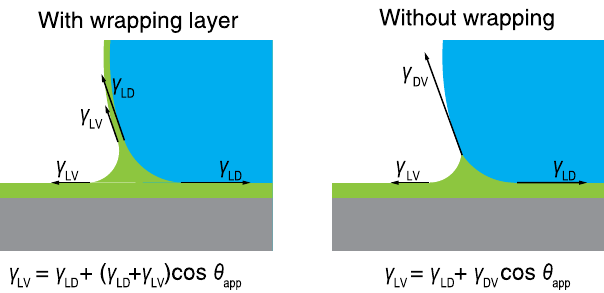
FIG. 7. The apparent contact angle θ of solely liquid-liquid and liquid-vapor interfacial